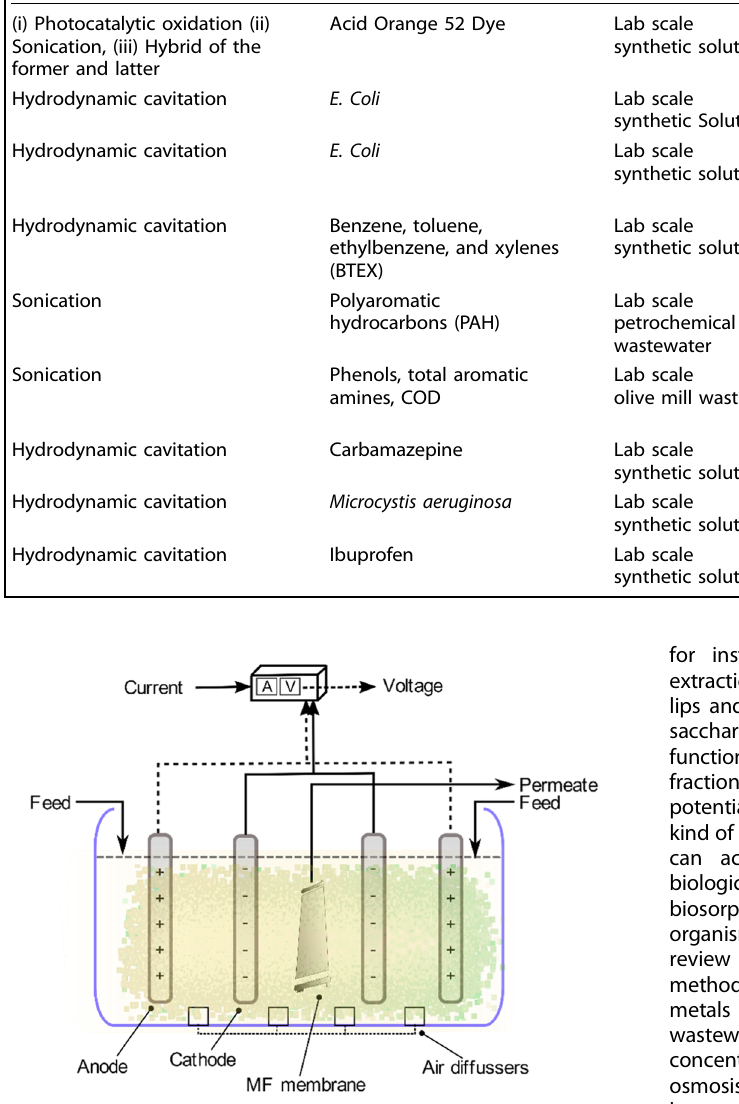
Table 7. Nature and extent of pollutants removal by sonication and hydrodynamic cavitation- assisted AOPs. Technique(s)